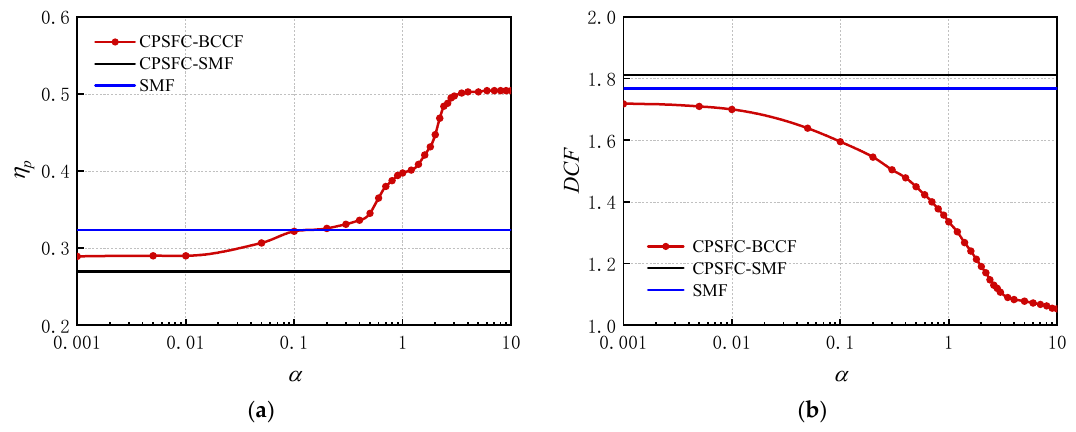
Figure 15. The stiffness analyses. ( a ) η p α curves and ( b ) DCF α curves.